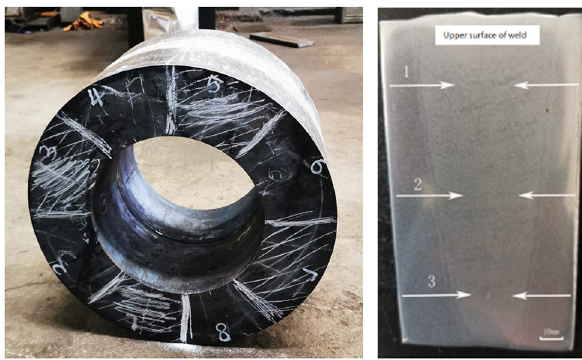
Figure 3: Schematic diagram of sampling position.